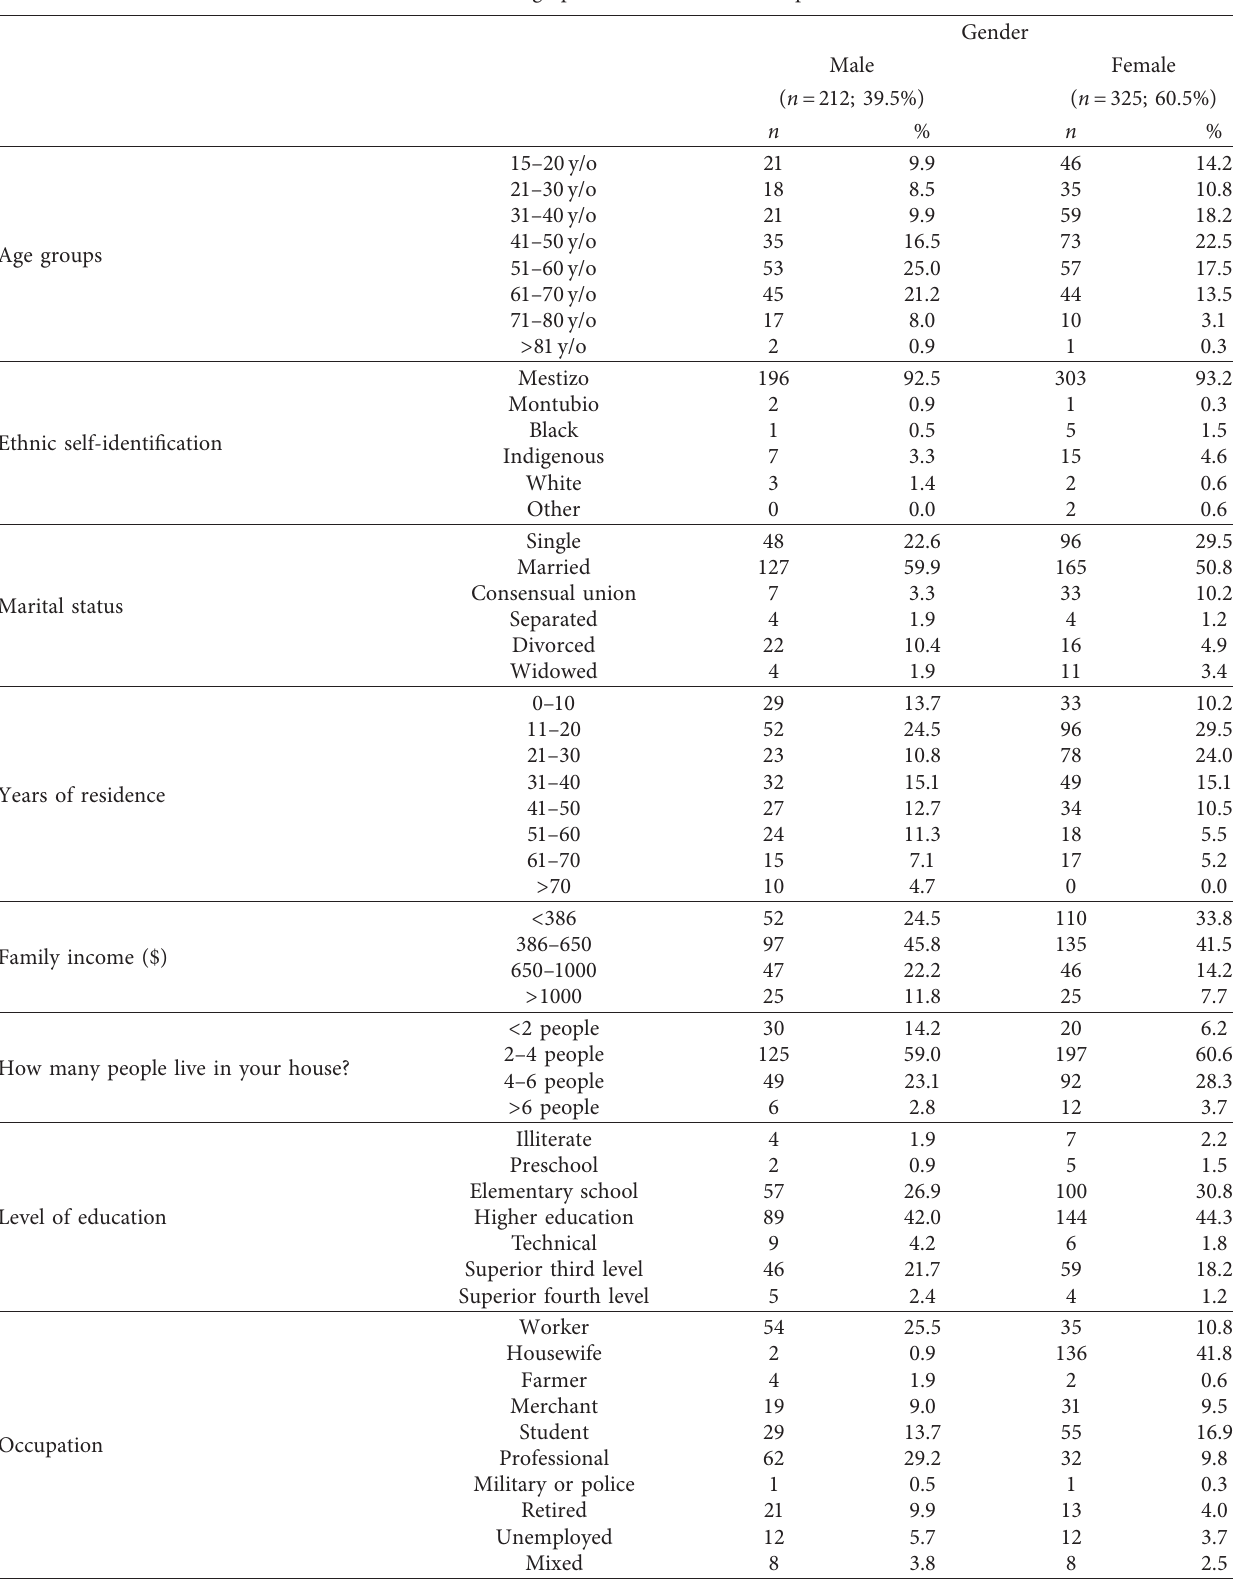
Table 1: Sociodemographic characteristics of